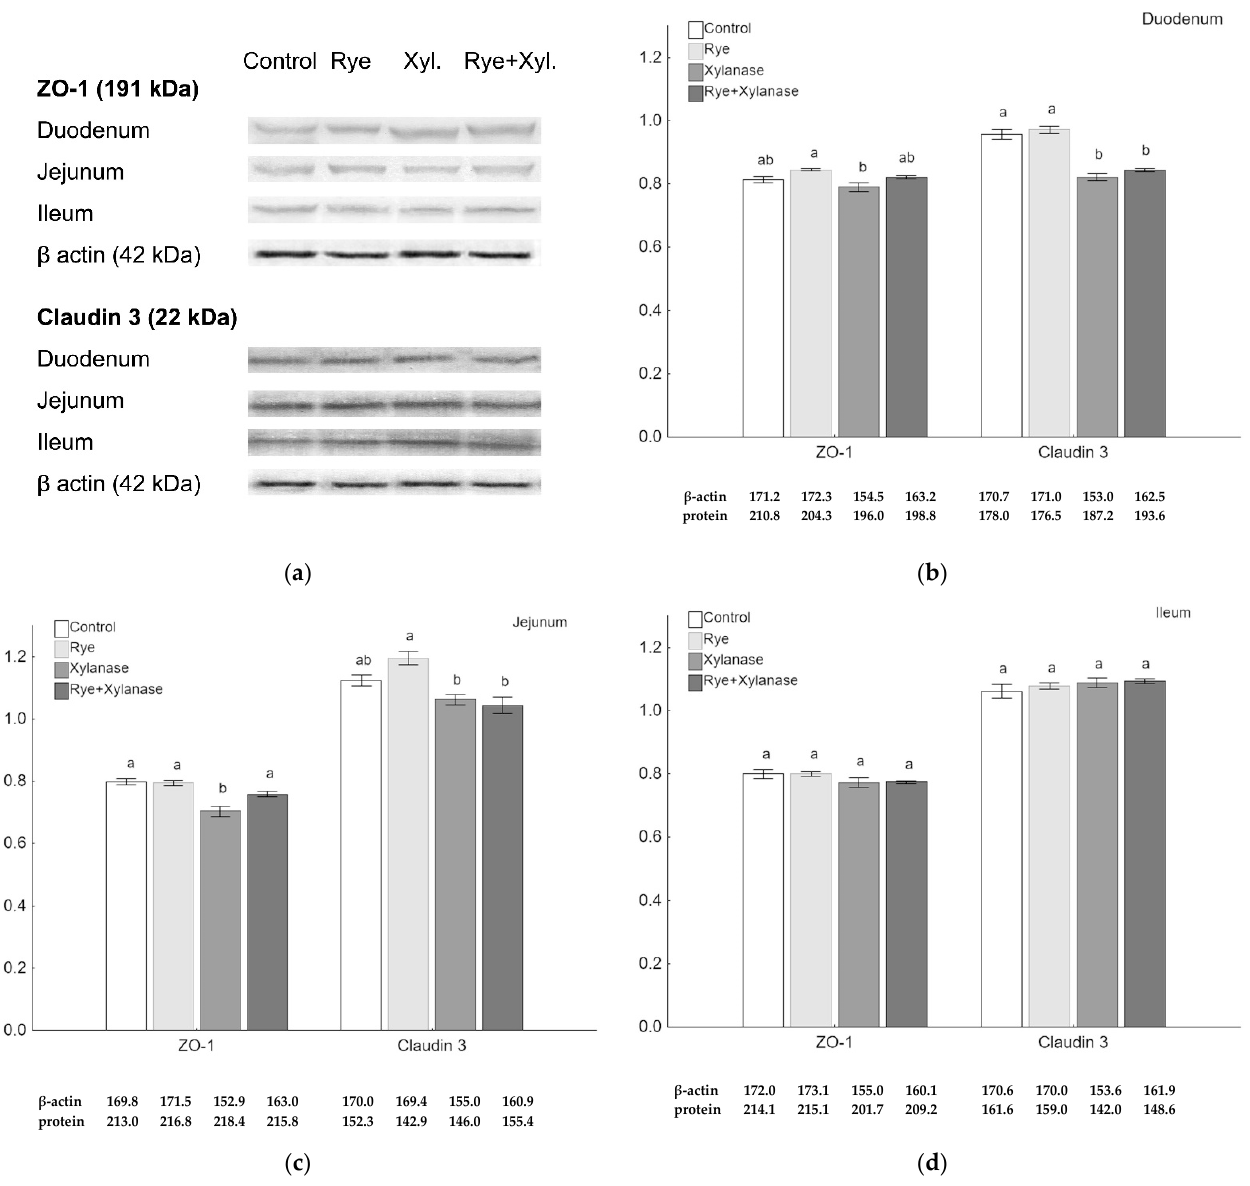
Figure 2. Protein expression in the epithelium of selected sections of the small intestine of broiler chickens. ( a ) Representative Western-Blots of examined proteins in the intestine epithelium obtained from broilers receiving no rye or xylanase in the feed (0% rye, 0 mg/kg xylanase), rye group (20% rye inclusion), xylanase-supplemented group (200 mg/kg of feed) and rye + xylanase (20% rye inclusion and xylanase 200 mg/kg of feed); ( b – d ) The relative abundance of ZO-1 and claudin 3, expressed as the mean ratio relative to β -actin of the respective sections of the small intestine; whiskers represent the SEM. Different letters ( a – c ) above the bars show differences at p < 0.05.